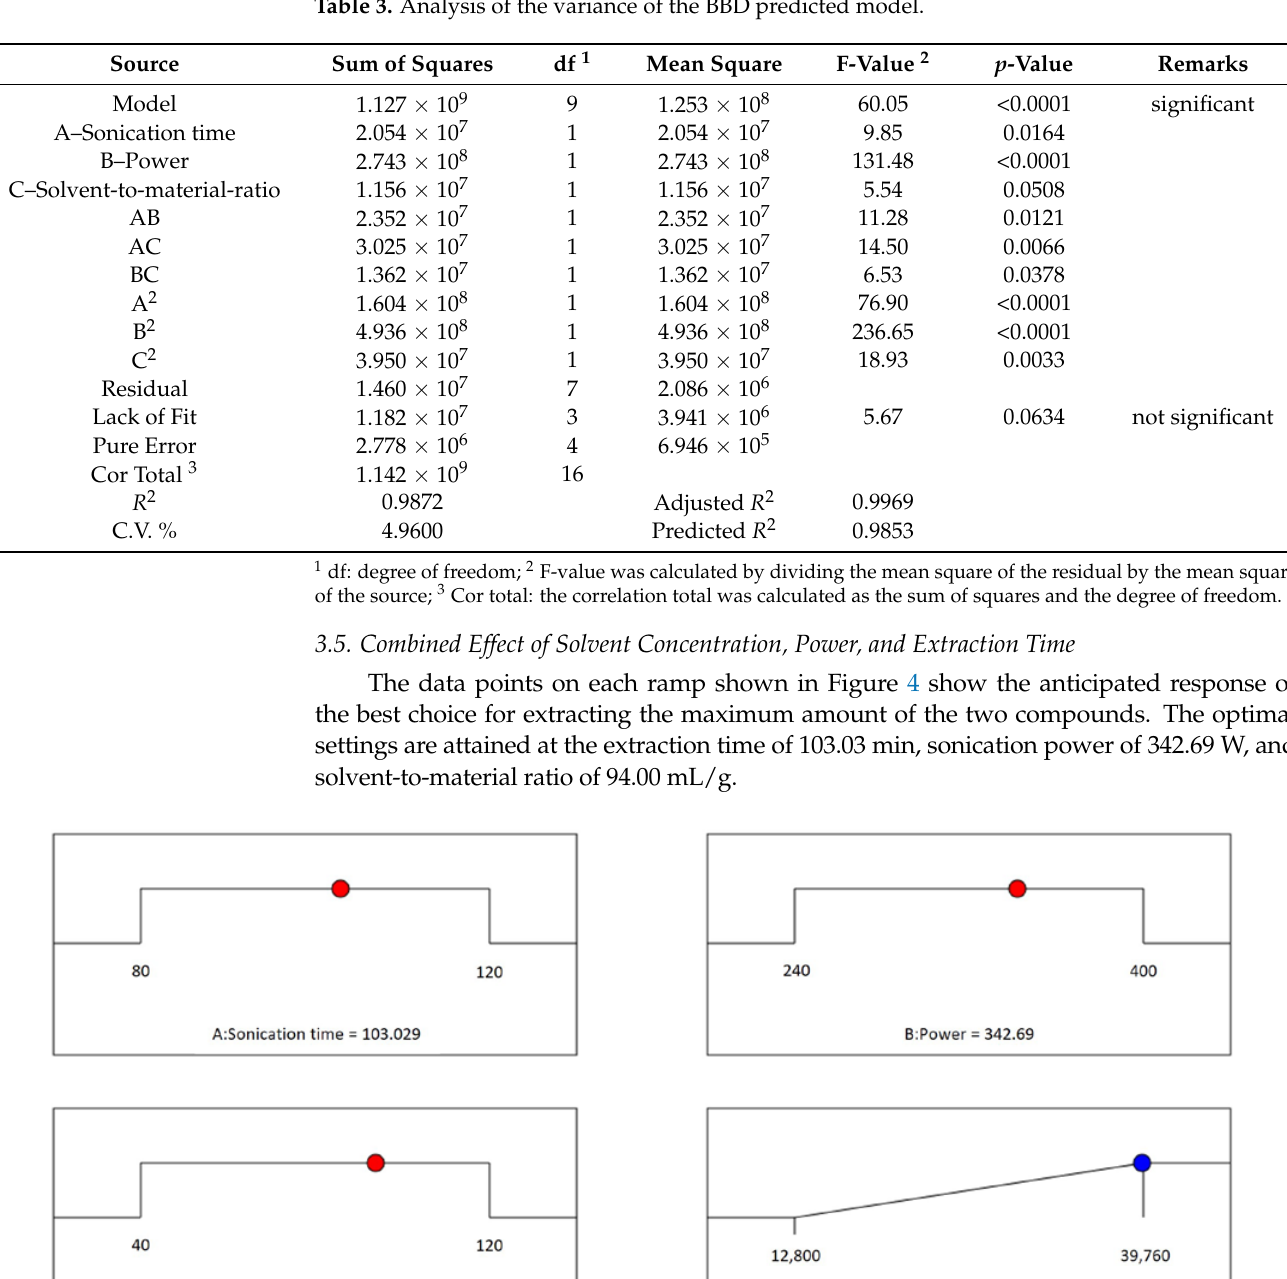
Table 3. Analysis of the variance of the BBD predicted model.